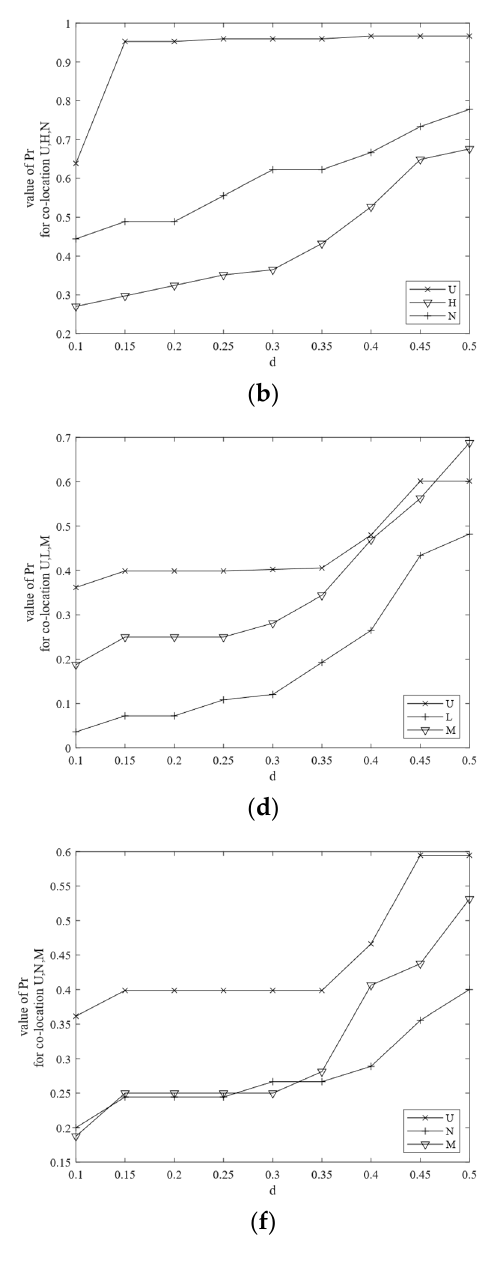
Figure 9. ( a ) Pr of co-location { U , H , L } ; ( b ) Pr of co-location { U , H , N } ; ( c ) Pr of co-location { U , H , M } ; ( d ) Pr of co-location { U , L , M } ; ( e ) Pr of co-location { U , L , N } ; ( f ) Pr of co-location { U , N , M }